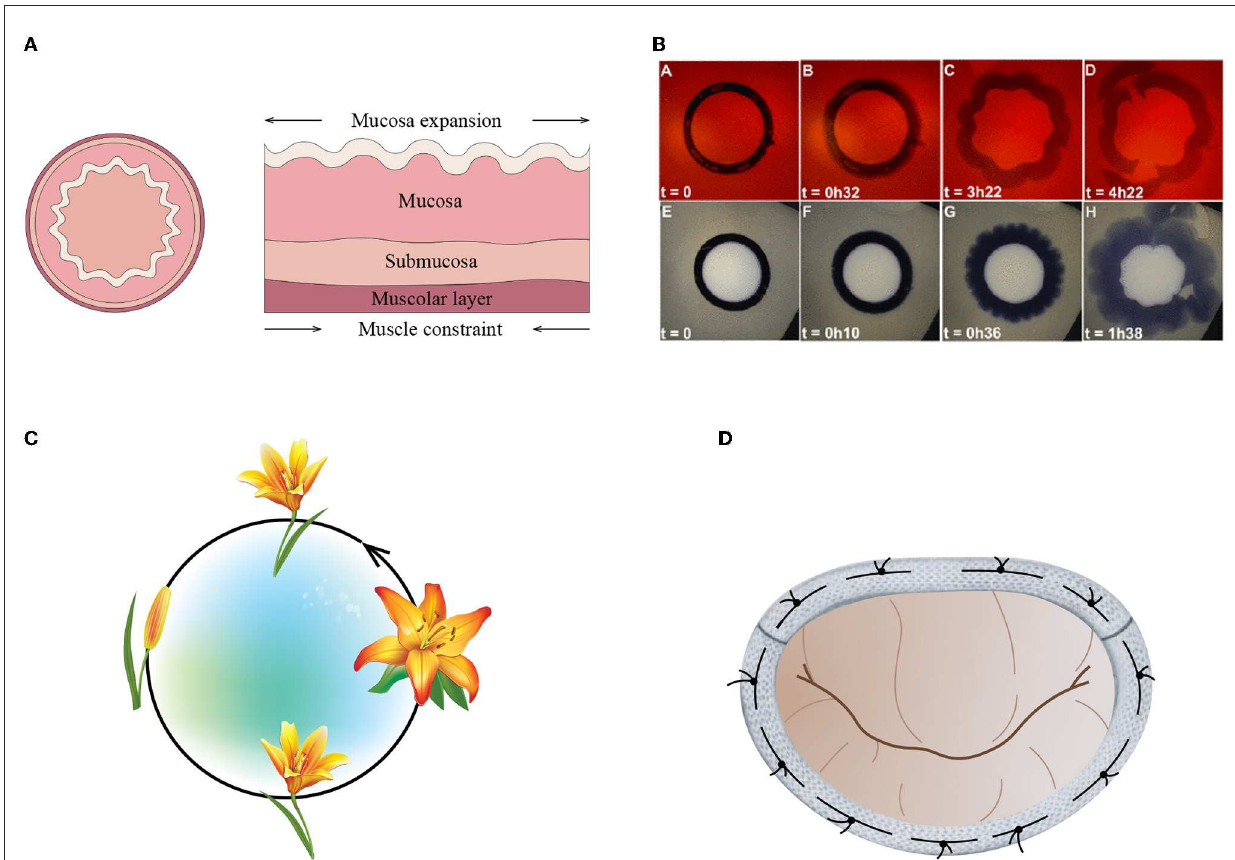
FIGURE2 (A) Schematic representation of the uniaxial patterns that develop in the lumen of human tubular structures (left) ; the organ wall structure in the digestive, respiratory, or reproductive tracts with the mechanism for the formation of the wavy morphology (right) . Redrafting of an original drawing of [17]. (B) Typical sequences of evolution for two thin circular artificial tumors confined at the periphery [18]. (C) Lily morphological transitions. (D) Mitral valve repair with an annuloplasty